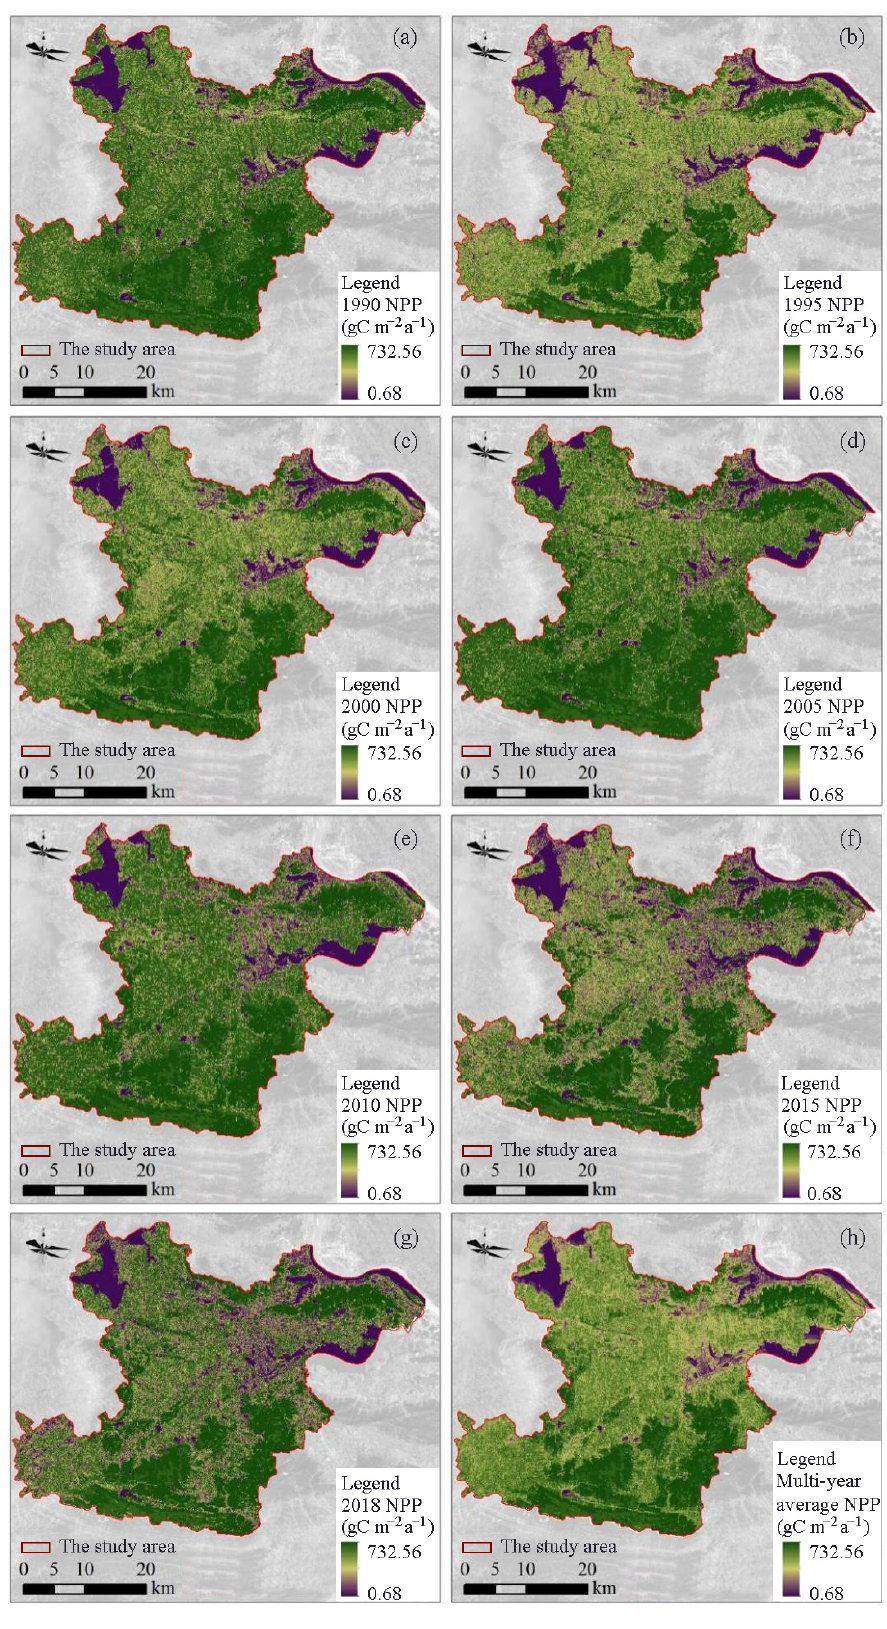
Figure 2. Spatial maps of NPP of the study area in 1990 ( a ), 1995 ( b ), 2000 ( c ), 2005 ( d ), 2010 ( e ), 2015 ( f ), and 2018 ( g ), and the average NPP ( h ) of the study area between 1990 and 2018.